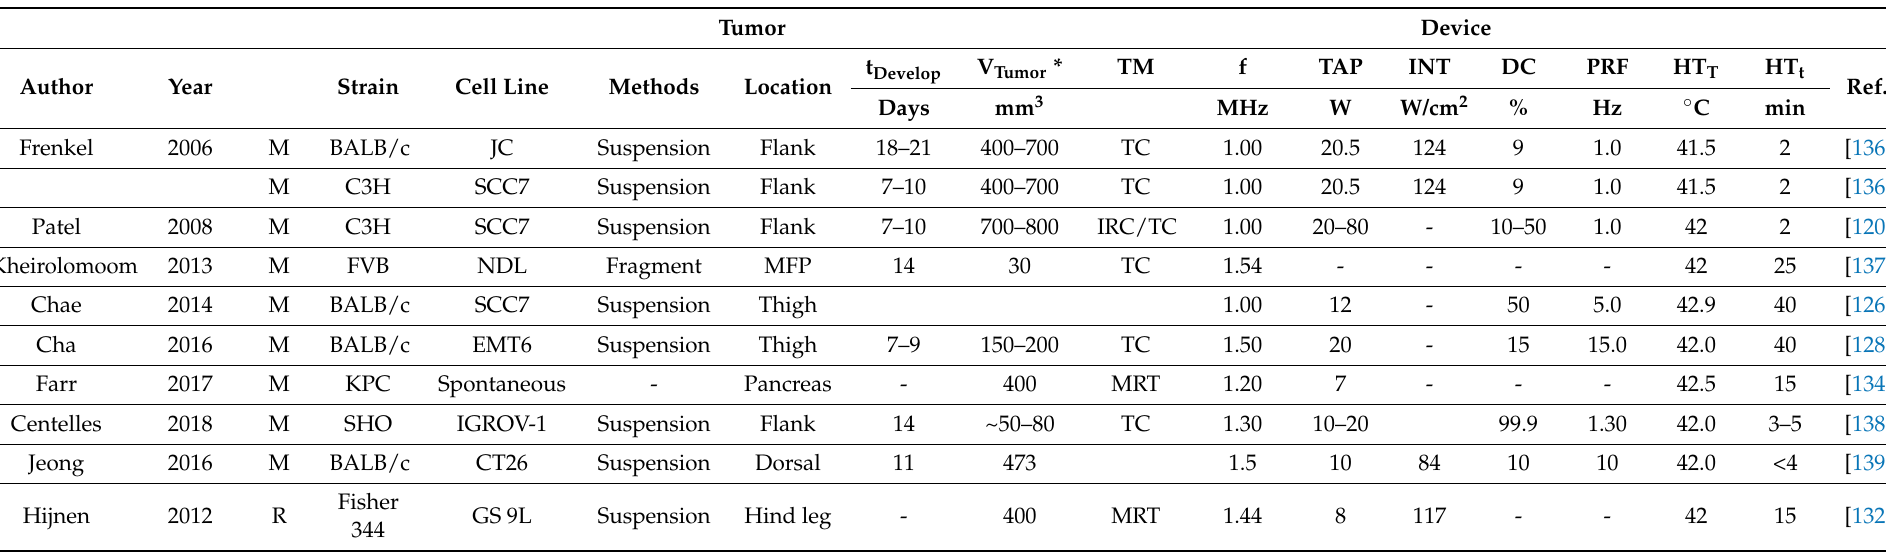
Table 4. Overview of the preclinical studies on application of local hyperthermia using focused ultrasound (FUS) sorted by year of publication and animal model.